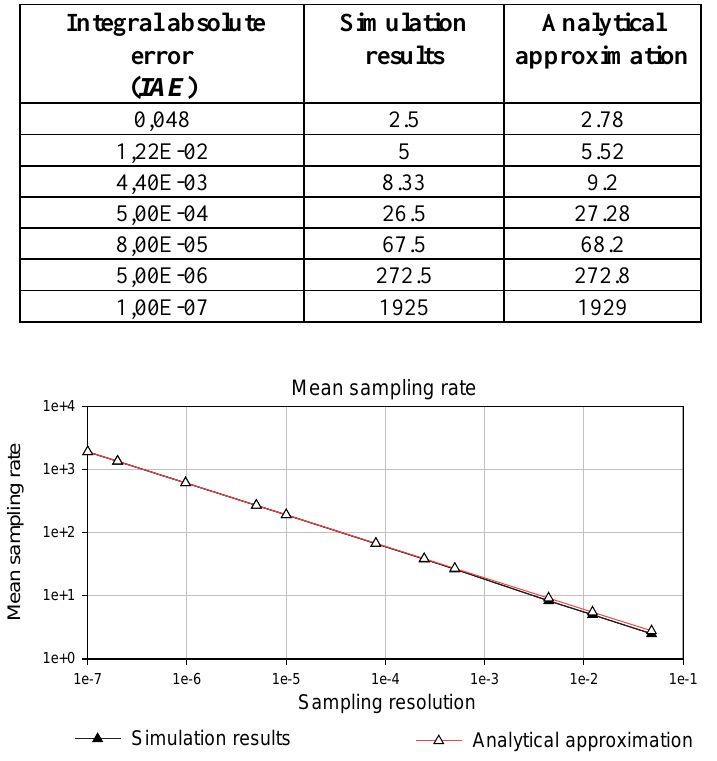
Table 1. Comparison of simulation results and analytical approximation for the mean sampling rate.